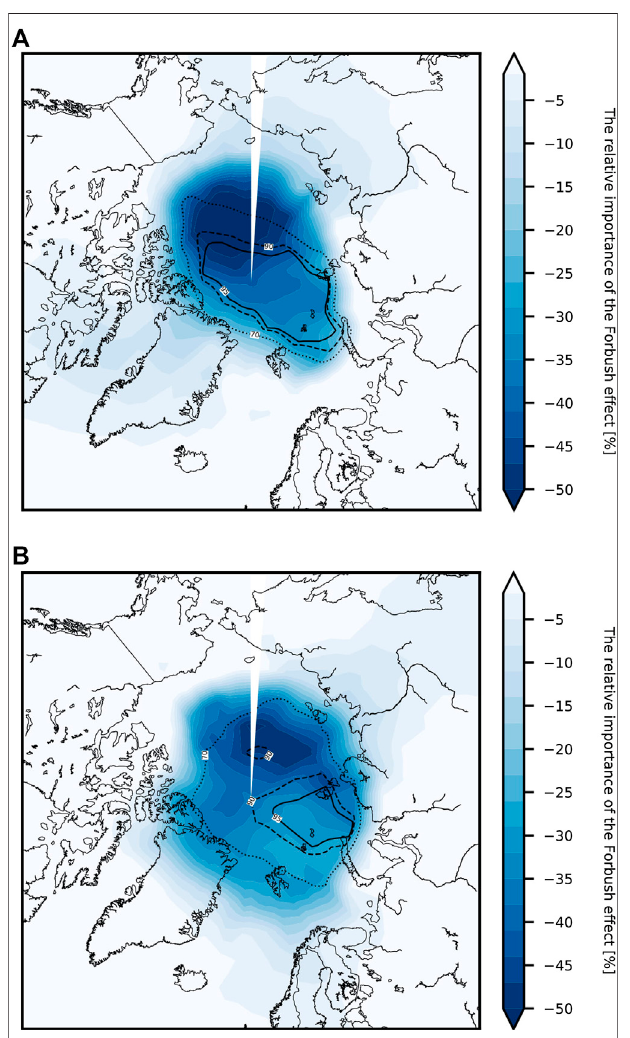
FIGURE 3 | The polar distribution of Forbush-induced effect in HO x simulated with CCM SOCOLv2 averaged for 1 – 300 hPa (A) January 18, 2005; (B) January 21, 2005. Solid line: area with con fi dence level of 95%. Dashed line: area with con fi dence level 90%; dotted line: area with con fi dence level 70%.